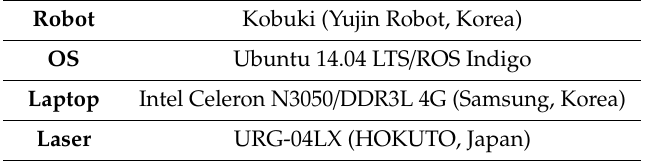
Table 3. Simultaneous localization and mapping (SLAM) settings. OS: operating system.